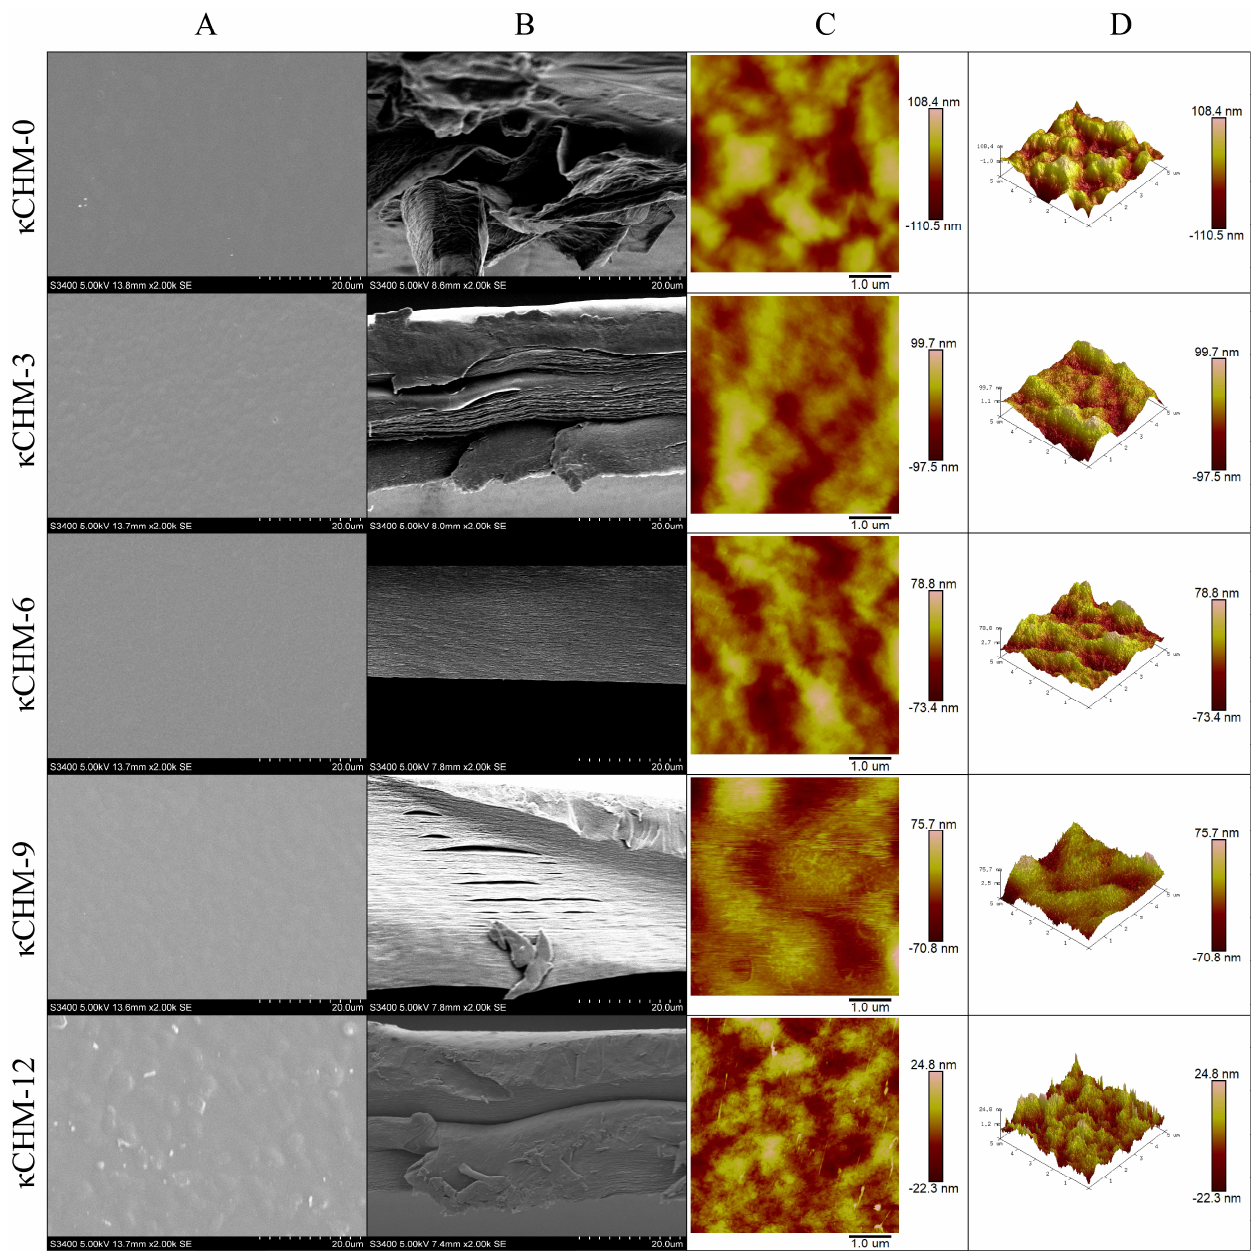
Figure 5. Morphological observations using scanning electron microscopy (SEM) and atomic force microscopy (AFM). ( A ) SEM images of surface and ( B ) cross-section of κCHM films. ( C ) AFM-2D and ( D ) AFM-3D images of the surface morphology of κCHM films. Table 3. Rq and Ra of the surface morphology of κCHM films.